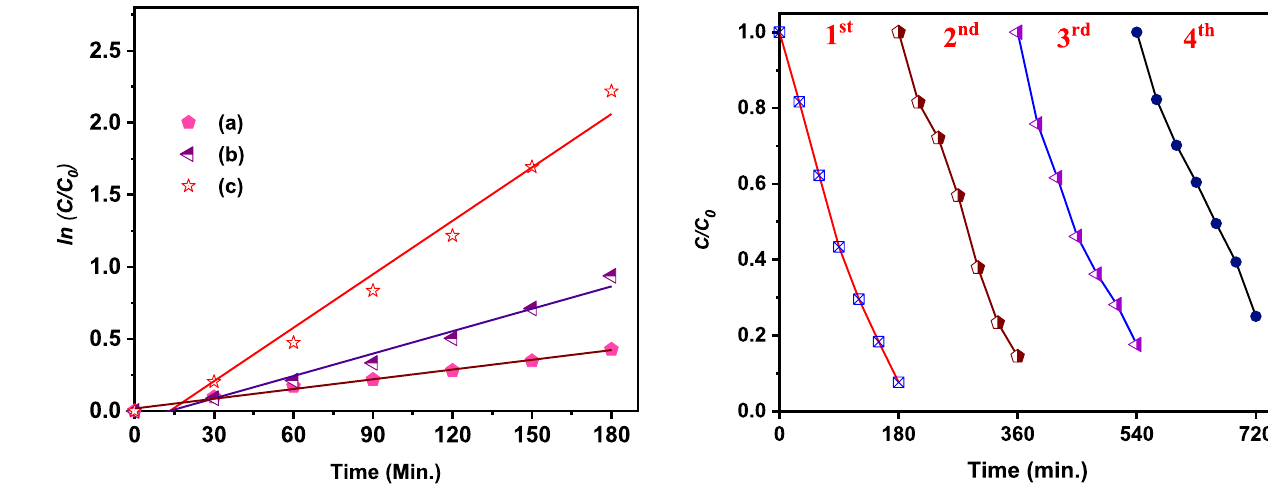
2 NPs for photo-